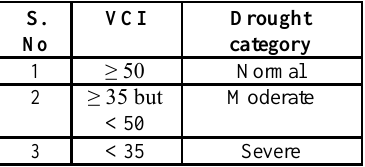
Table 1 VCI classification for agricultural drought Monitoring Figure 2 Drought intensity maps for 20 years during June